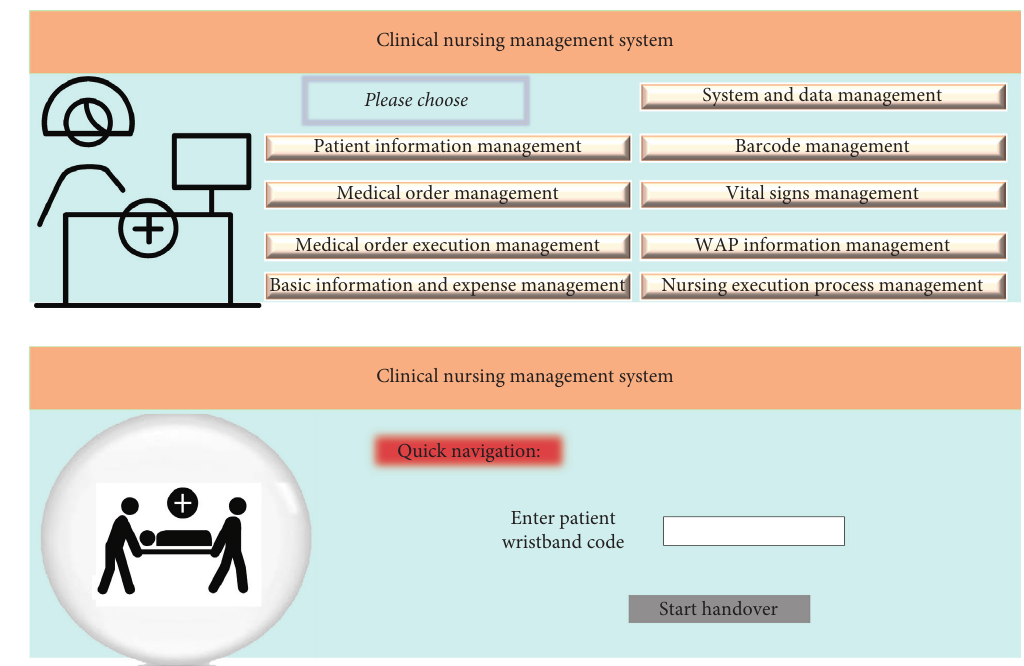
Figure 7: Implementation interface of basic patient management functions.